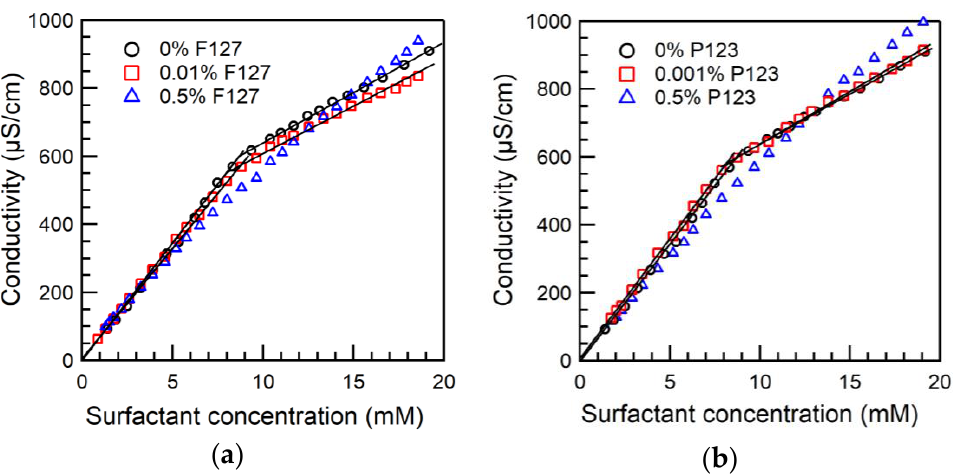
Figure 1. Conductivity of SDS aqueous solutions in the absence and in the presence of ( a ) 0.01% or 0.5% Pluronic F127 and ( b ) 0.001% or 0.5% Pluronic P123, plotted as a function of surfactant concentration (22 °C).